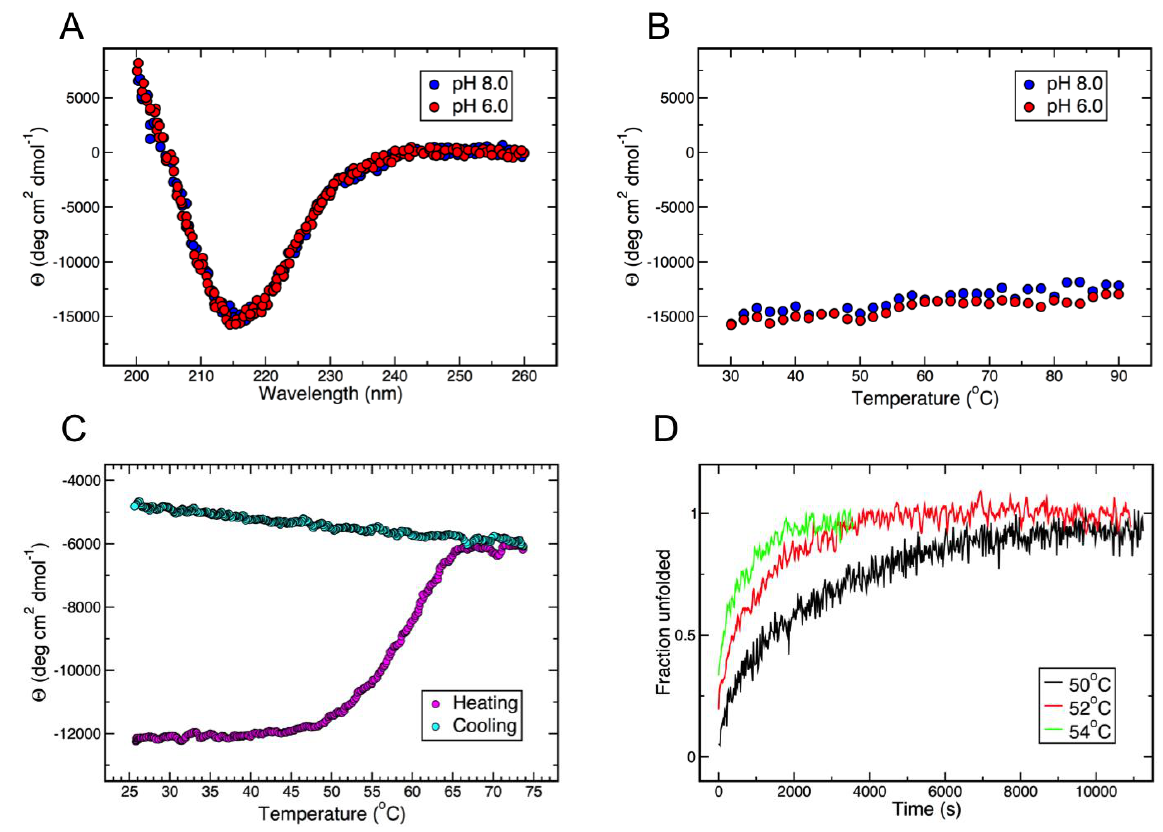
Figure 3. The gp5 β -BC fragment is extremely resistant to thermal and chemical denaturation. ( A ) CD spectra in 20 mM Sodium Phosphate buffer at pH 6.0 and 8.0; ( B ) Temperature-induced unfolding is monitored by the depth of the β -structure signature peak at 215 nm; ( C ) Thermal denaturation in the presence of 6 M guanidinium is irreversible; ( D ) Kinetics of unfolding in 6 M guanidinium after incubation at different elevated temperatures.